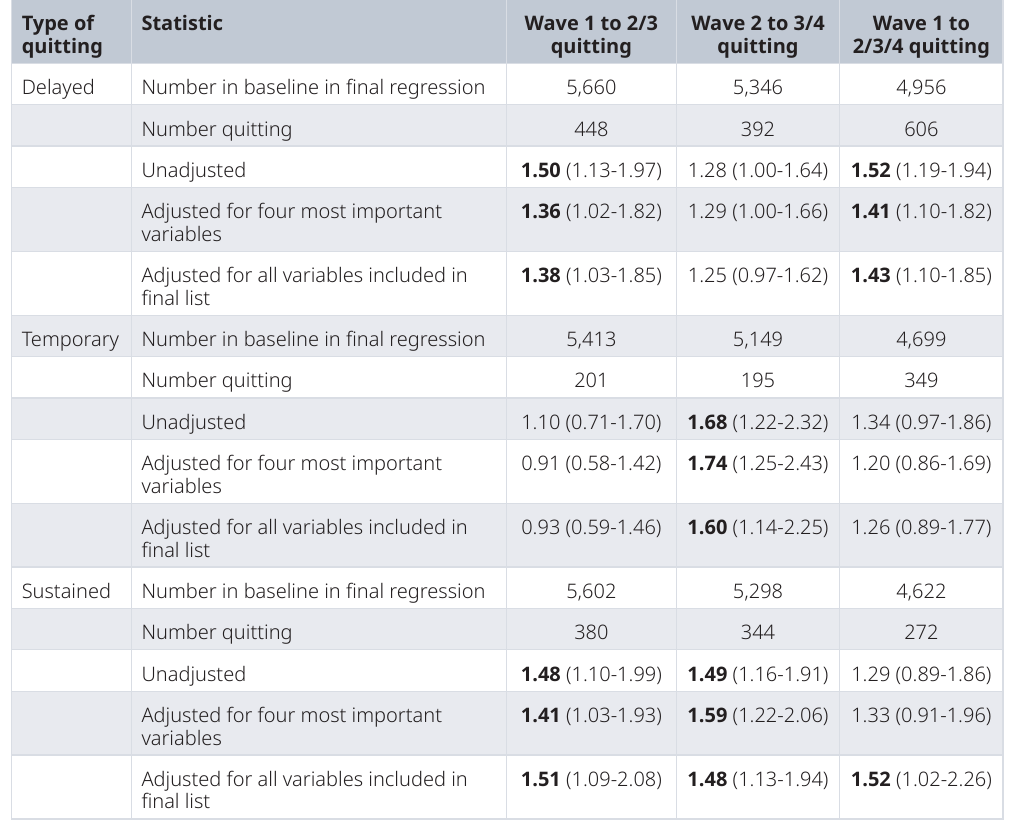
Table 6. Effect of adjustment on the OR (95% CI) for the relationship of ever regular e-cigarette use a to